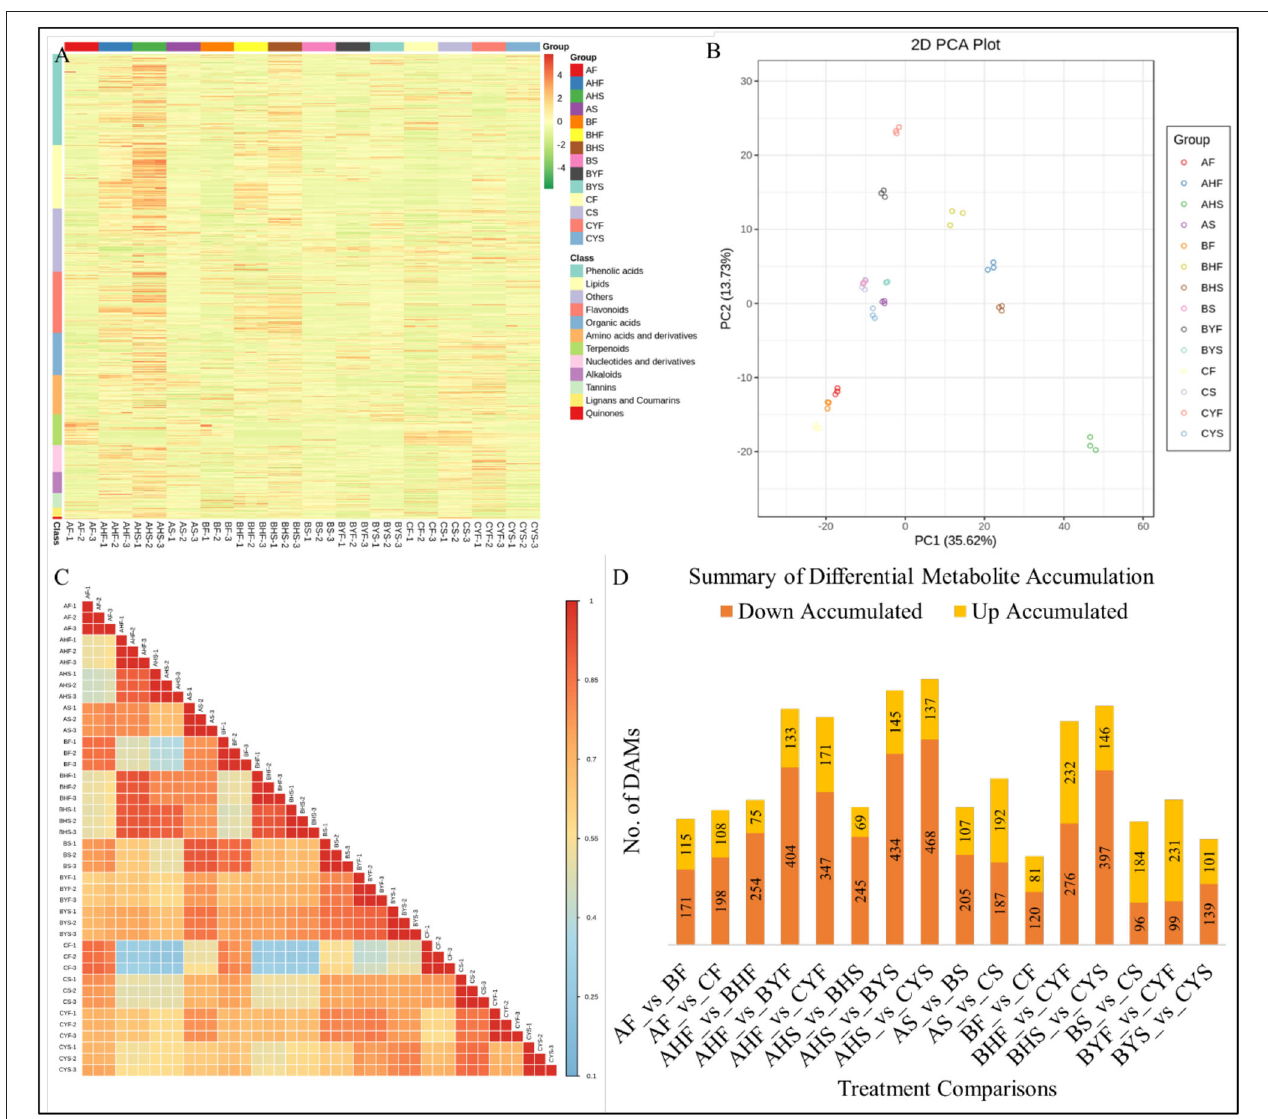
FIGURE 7 | Summary of the metabolite profiling of mango tissues. (A) A heatmap of the relative content of the 1023 detected metabolites, (B) principal component analysis, (C) Pearson’s correlation coefficient, (D) the number of upregulated or downregulated metabolites among the studied tissues of mango varieties A, B, and C, where A indicates Lippens), B indicates Banana Mango), and C indicates Linsen Mango). The tissue names are according to Table 1